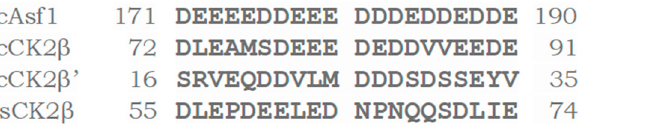
Figure 1. Sequence alignment of yeast Asf1 aa 171-190, yeast (Sc) CK2 β aa 72-91, yeast (Sc) CK2 β ’ aa 16-35, and human (Hs) CK2 β aa 55-74.